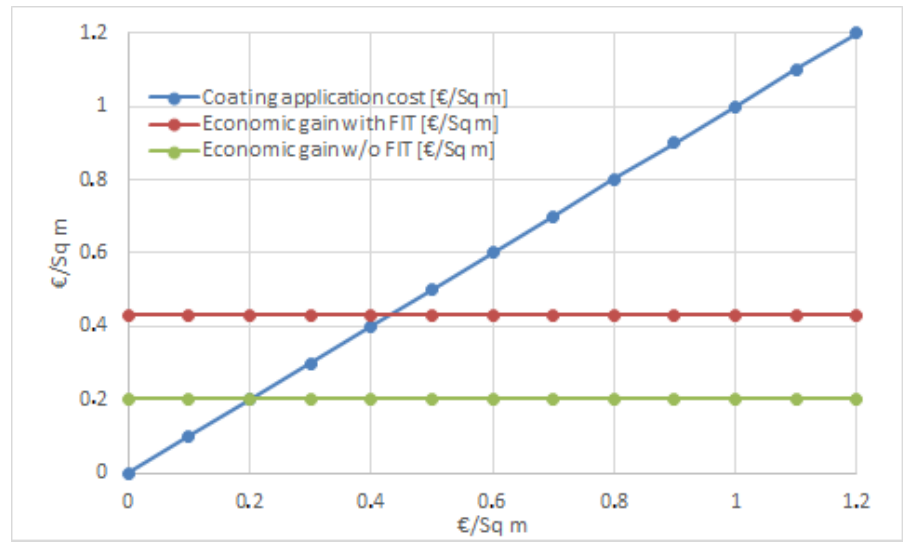
Figure 9 Figure 9. Coating application cost vs. coating economic gains with and without